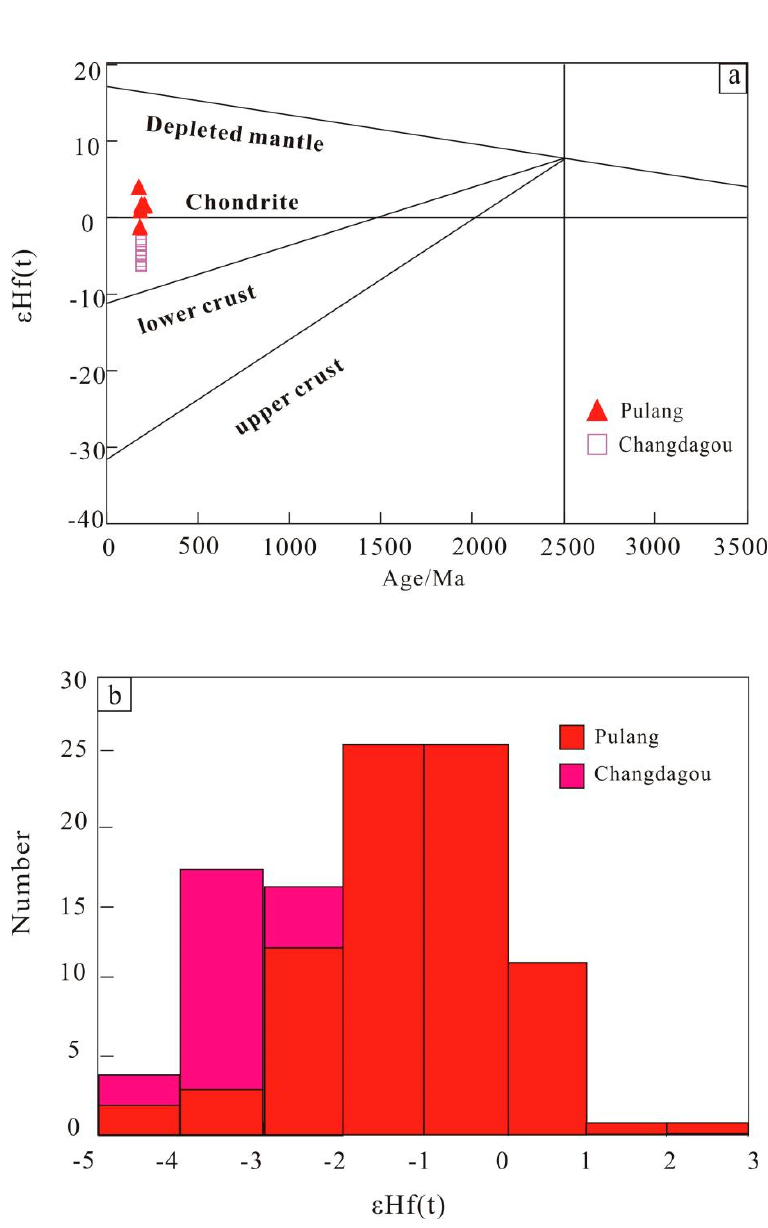
Figure 8. ( a ) Diagram of ε Hf(t) vs. U-Pb ages. ( b ) Histogram of ε Hf(t) values.